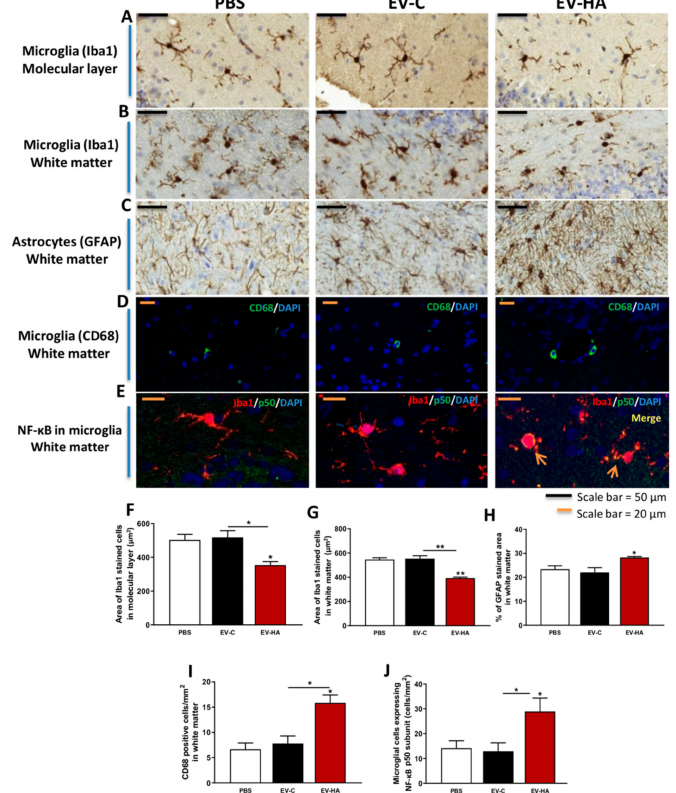
Figure 6. E ff ects of injected vesicles on microglial and astrocytic activation in cerebellum analyzed by immunohistochemistry / immunofluorescence. Representative images of ( A ) immunohistochemistry against Iba-1 in molecular layer and ( B ) white matter, ( C ) immunohistochemistry against GFAP in white matter, ( D ) immunofluorescence of CD68 in white matter and ( E ) NF-kB p50 subunit expression in microglial cells in white matter. ( F ) Area of microglia (Iba1 stained cells) in molecular layer and ( G ) white matter. ( H ) Percentage of GFAP stained area in white matter. ( I ) Number of activated microglia (CD68 positive cells) in white matter. ( J ) Number of microglial cells expressing NF-kB p50 subunit per mm 2 in white matter. One-way ANOVA with Tukey post-hoc test was performed to compare all groups. Values are the mean ± SEM of 3-4 rats per group. Values significantly di ff erent from PBS-injected rats are indicated by asterisk (* p < 0.05, ** p <